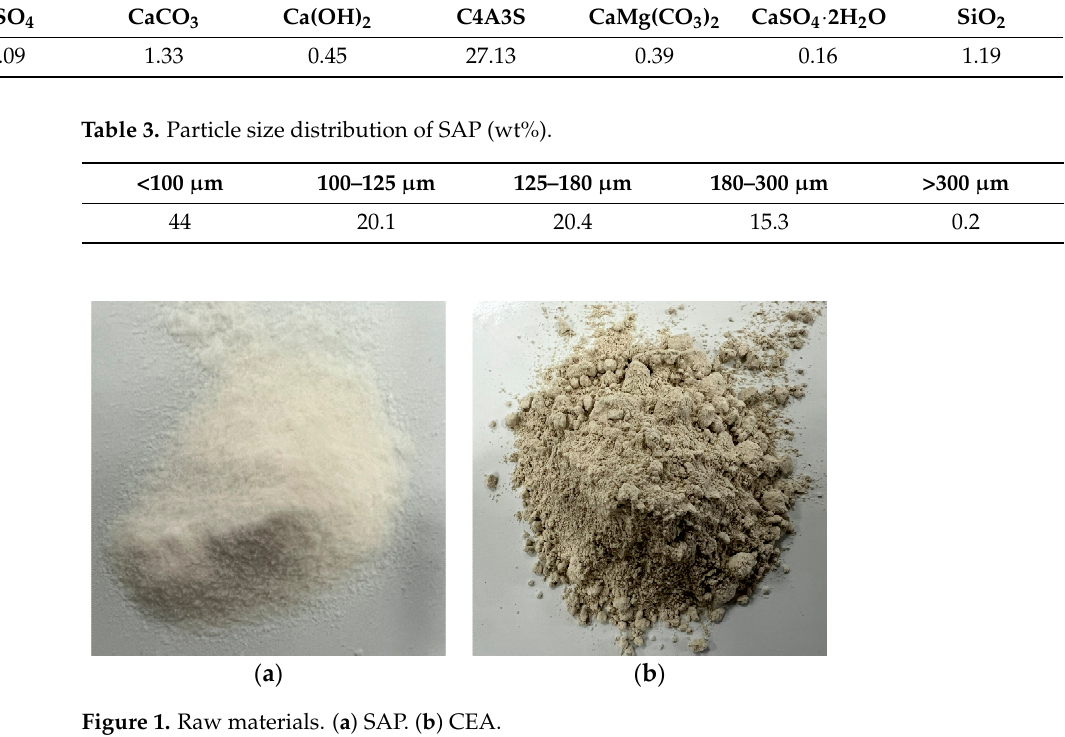
Table 2. Phase composition of CEA (wt%).